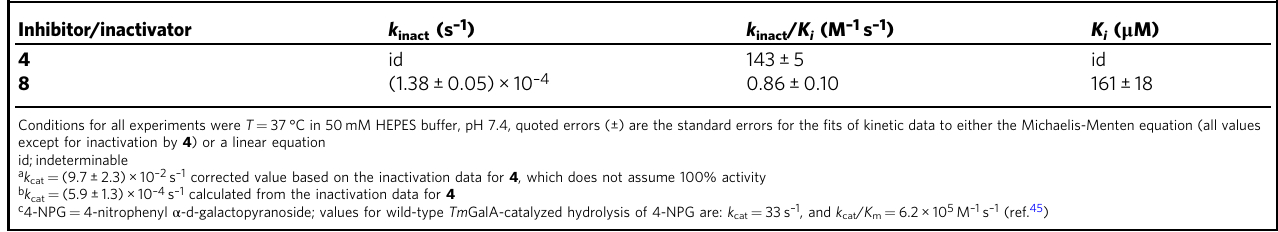
Table 1 Kinetic parameters for the Tm GalA-catalyzed reactions with 3b and 4 Hydrolysis substrates